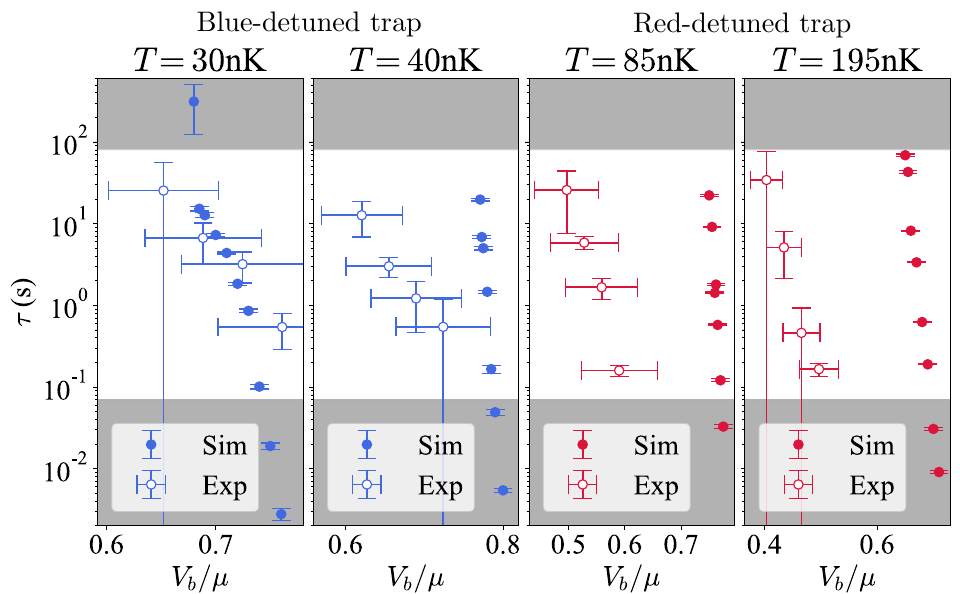
Figure 7: Comparison of the superflow lifetime τ between simulations (closed cir- cles) and experiment (open circles) as a function of normalised barrier height V for the four different temperatures studied in the experiment. Error bars on the ex- perimental data give a 95% confidence interval. The grey shaded areas denote the timescales that sit outside the estimated range of values detectable by the experi- ment. The simulation and experimental data show strong quantitative agreement for T = 30nK, however there is an increasing discrepancy at higher